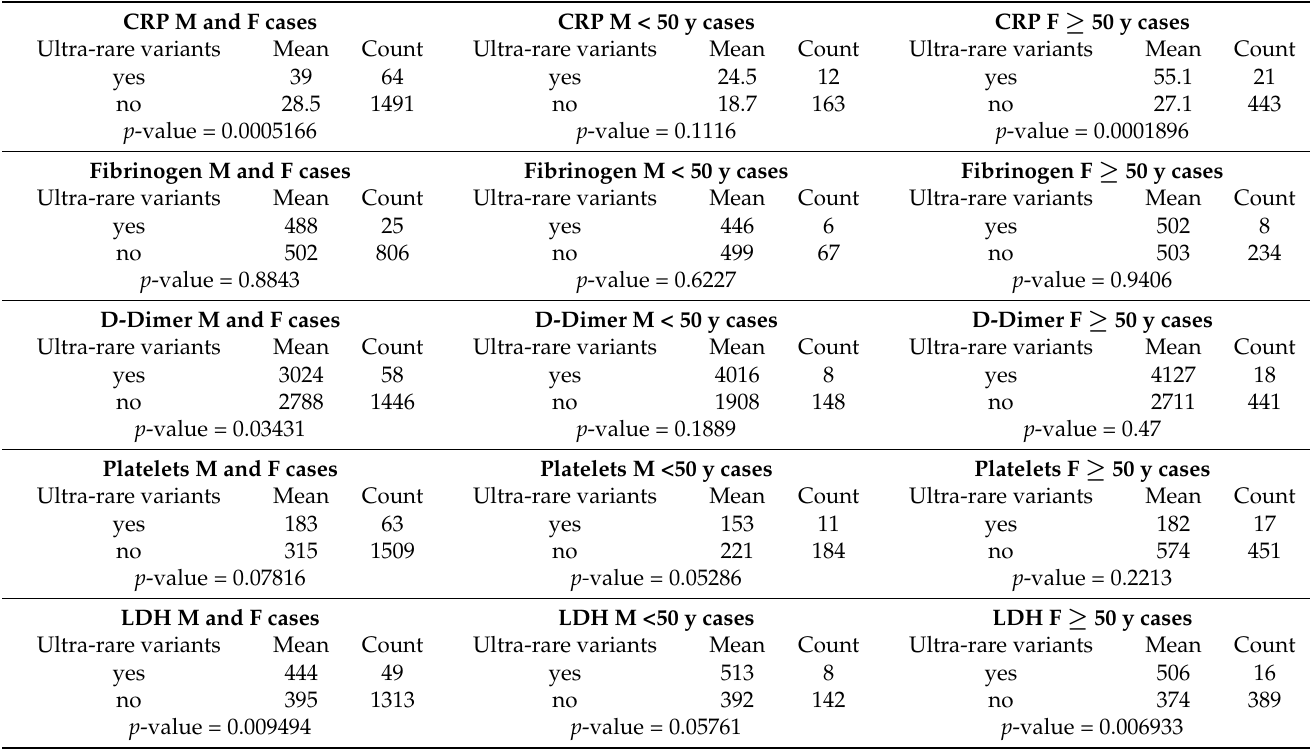
Table 3. Correlations between ADAMTS13 ultra-rare variants and laboratory values in hospitalized